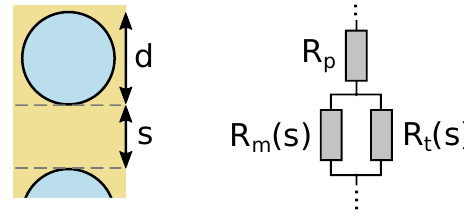
Figure 2. Resistor model from one particle to the